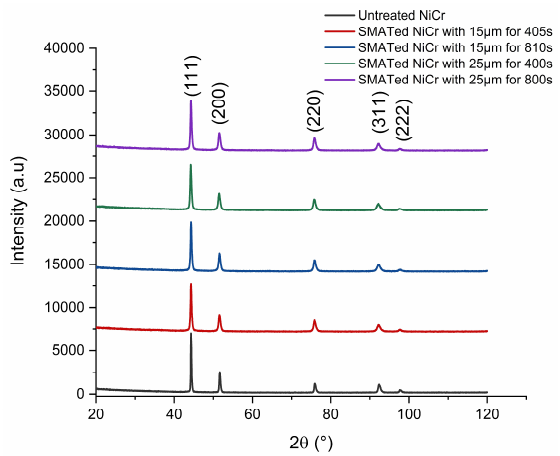
Figure 6 . X-ray diffraction patterns of Ni–Cr coatings before and after SMAT at different conditions.